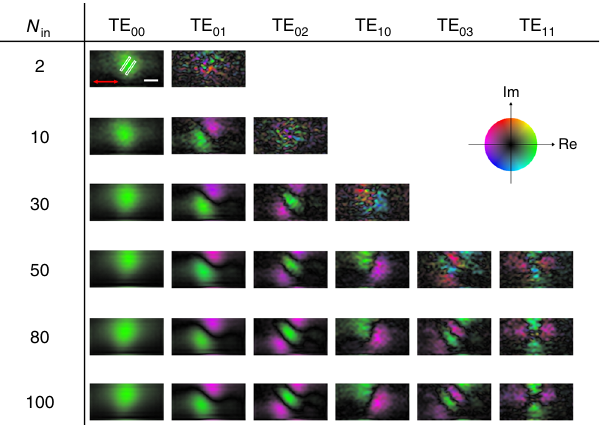
Fig. 3 Sensitivity of near- fi eld mode mapping depending on the number of incidence angles. Among the 100 different k in measurements, N in = 2, 10, 30, 50, 80, and 100 measurements were used to construct FNTMs, and the corresponding near- fi eld eigenmodes are shown. Circular color map: real and imaginary values of the complex fi eld. The white rectangles outline the boundaries of the nano-slits. Scale bar, 150